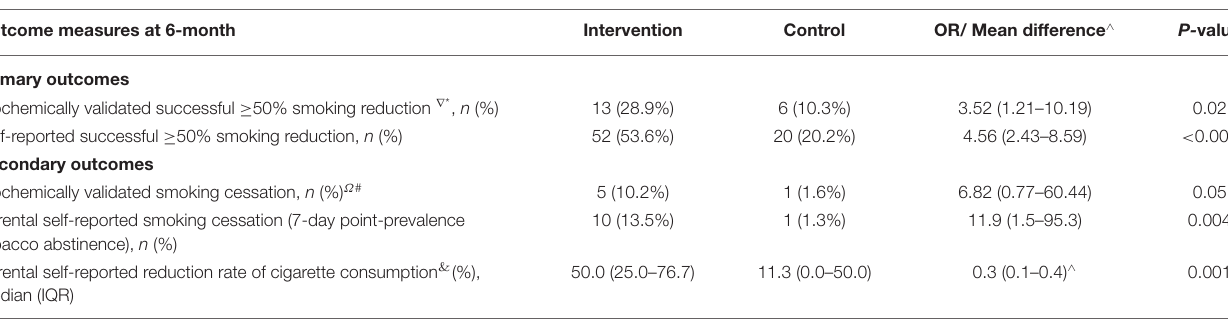
TABLE 6 | Primary and secondary outcomes (sensitivity